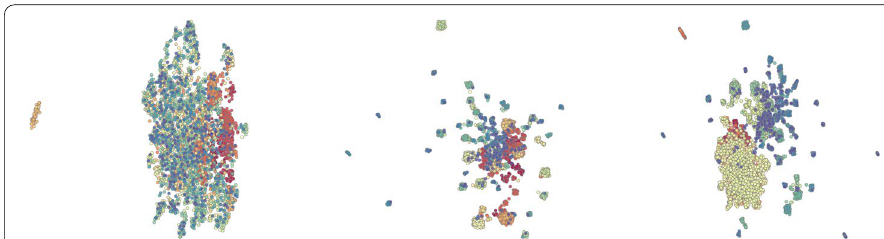
Fig. 4 Node2vec embedding of the networks using UMAP (left: G ′ P , middle: G ′ S , right: G ′ )